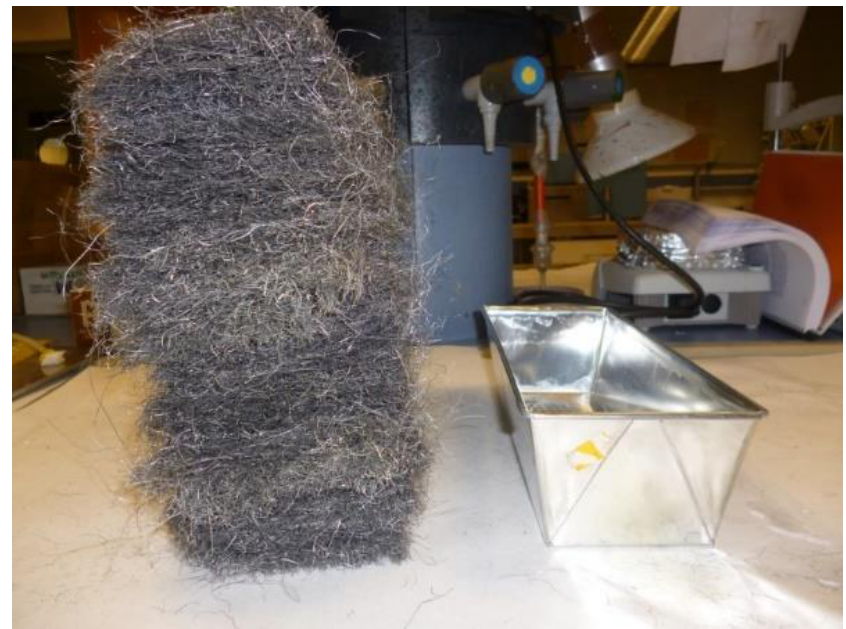
Figure 6. Metal wool and mold used in the casting laboratory trials.